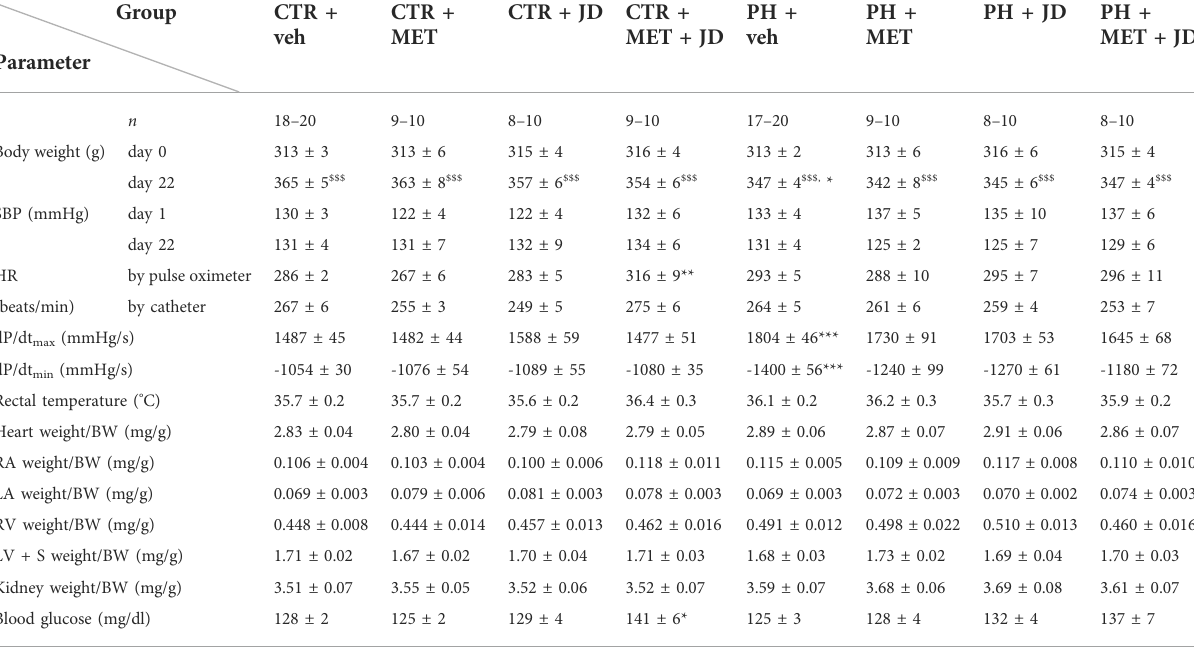
TABLE 1 In fl uence of metformin (MET), JD5037 (JD) and their combination (MET + JD) on physiological parameters of monocrotaline-induced pulmonary hypertensive (PH) rats and their normotensive controls (CTR).